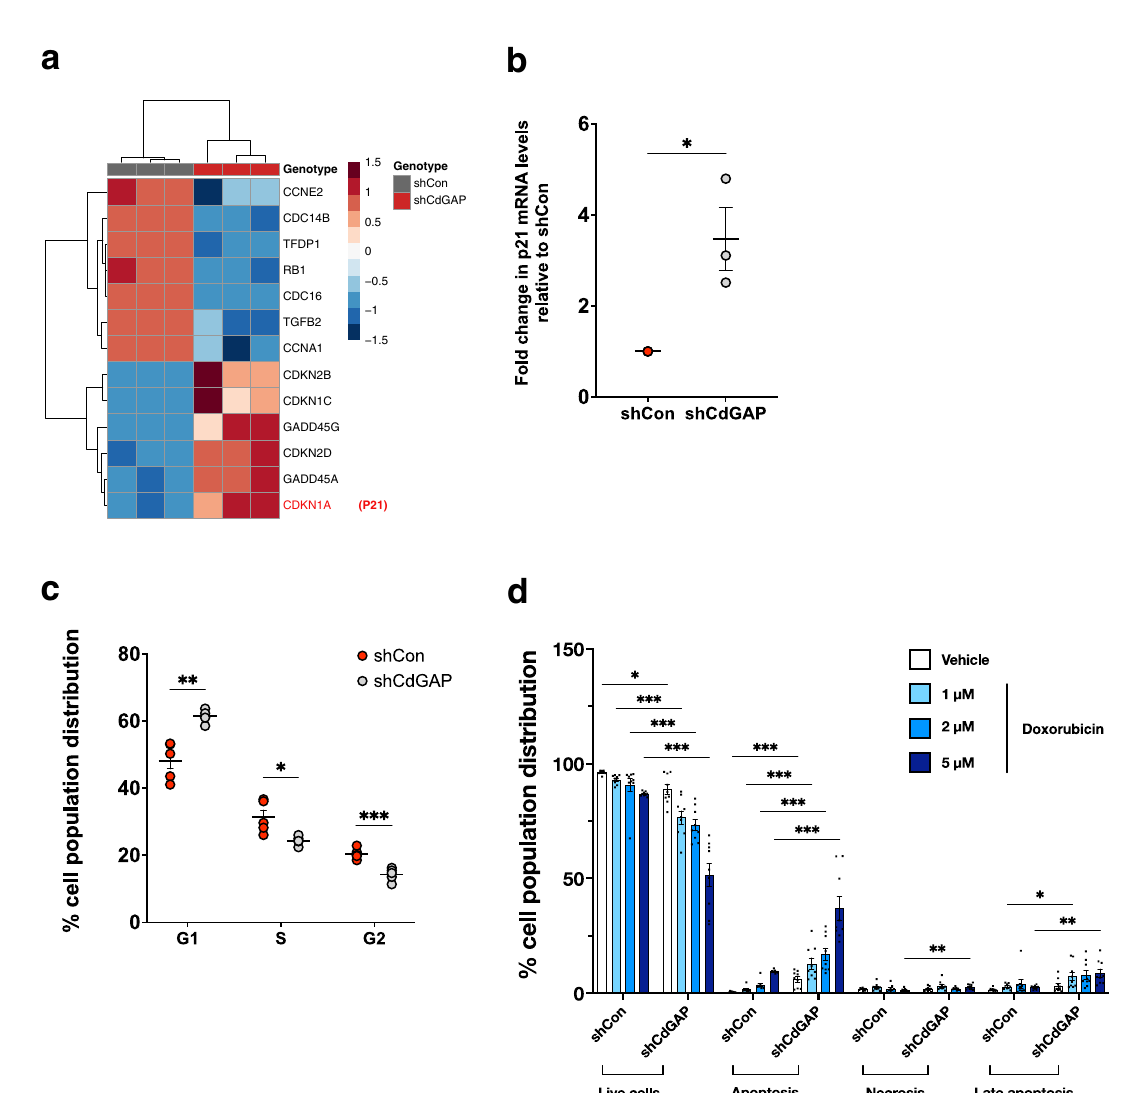
Fig. 6 CdGAP regulates G1 cell cycle progression and apoptosis. a Heatmap depicting cell-cycle checkpoint genes altered in CdGAP-depleted cells. b p21 mRNA levels in shCon (control) and shCdGAP PC-3 cells ( n = 3). c Flow cytometry analysis of cell cycle distribution for CdGAP-depleted (shCdGAP) and control PC-3 cells. Cell cycle distribution is represented as the percentage of cells at each phase ( n = 3). d Flow cytometry analysis of cell death in CdGAP- depleted (shCdGAP) and control PC-3 cells treated with doxorubicin (1, 2, and 5 µ M) or vehicle (DMSO 0.05%) for 12 h. The percentage of cell population distribution (live, apoptosis, necrosis, late apoptosis) is represented ( n = 3). Two-sample unpaired Student ’ s t test for comparison between two groups (shCon; shCdGAP). Error bars indicate SEM. ***p < 0.001; ** p < 0.01; * p <